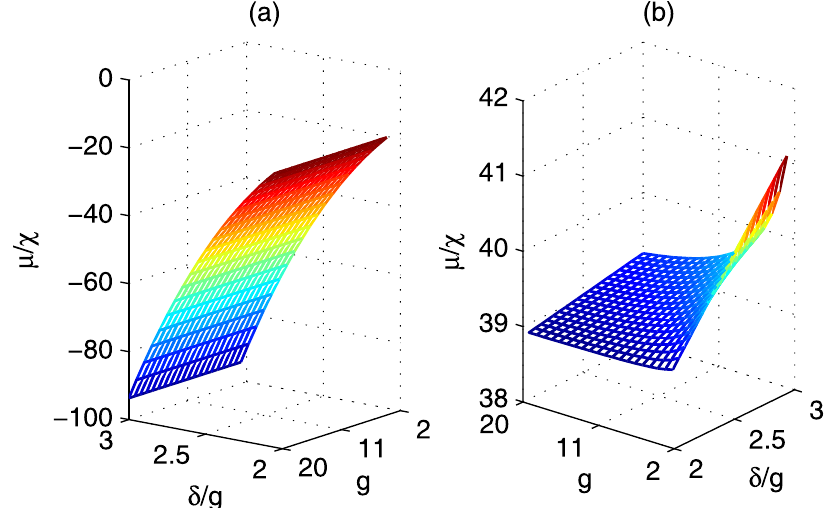
Figure 5. μ / χ vias δ / g and g . ( a ) Δ 1 = 4 g , Δ 2 = 4 g + δ , ν = g , Ω = g ; ( b ) Δ 1 = 9 g , Δ 2 = 9 g + δ , ν = 4 g , Ω = g 3 .